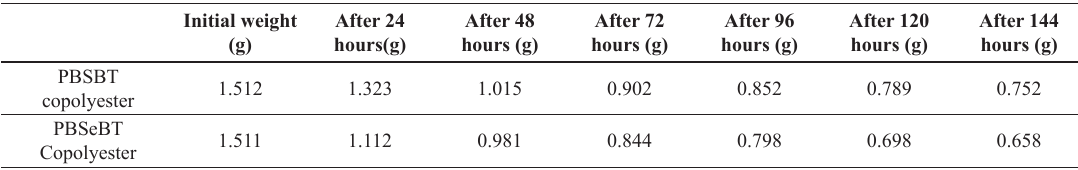
Table.3: Weight loss of copolyester in (0.1N NaOH) alkaline test